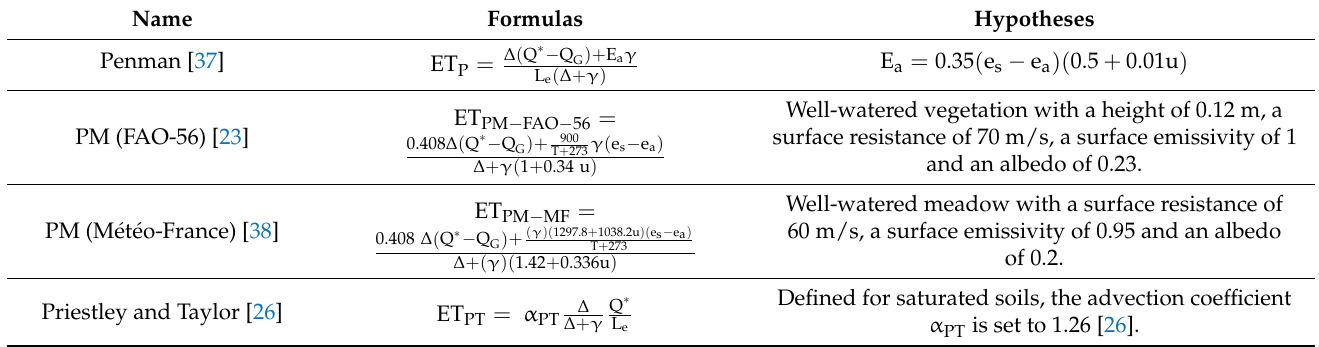
Table 3. Evapotranspiration (ET)’s formulations used in this study. The FAO and M é t é o-France formulations are two ways of setting parameters for Penman-Monteith (PM)